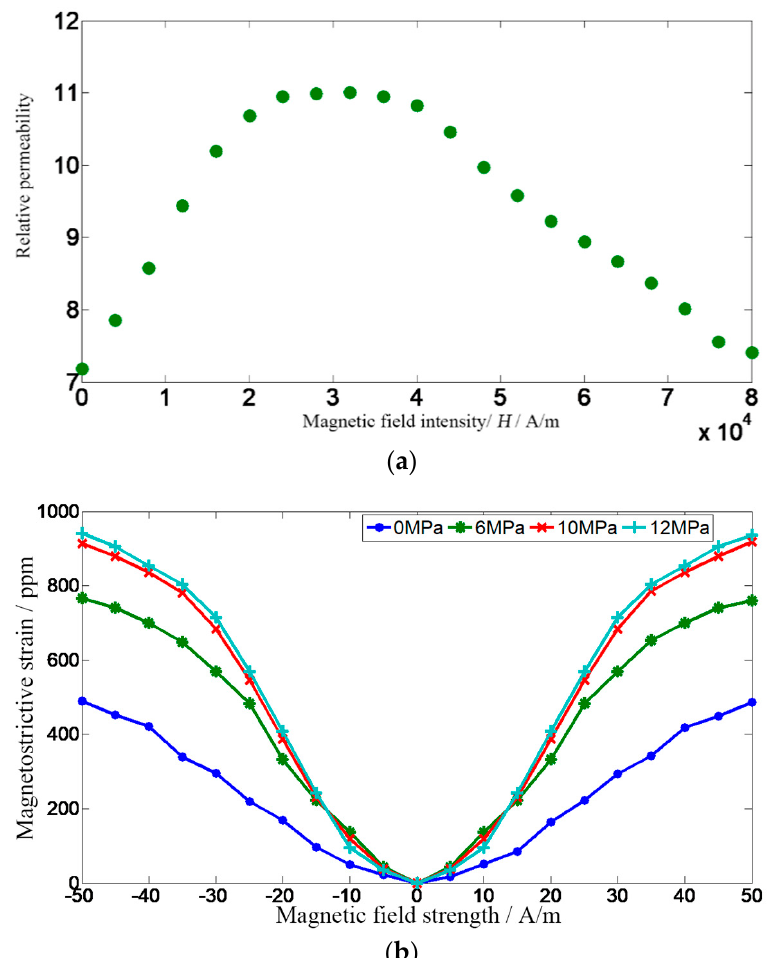
Figure 5. ( a ) Relative permeability of GMM and magnetic field strength. ( b ) Magnetostrictive strain of GMM and magnetic field strength.